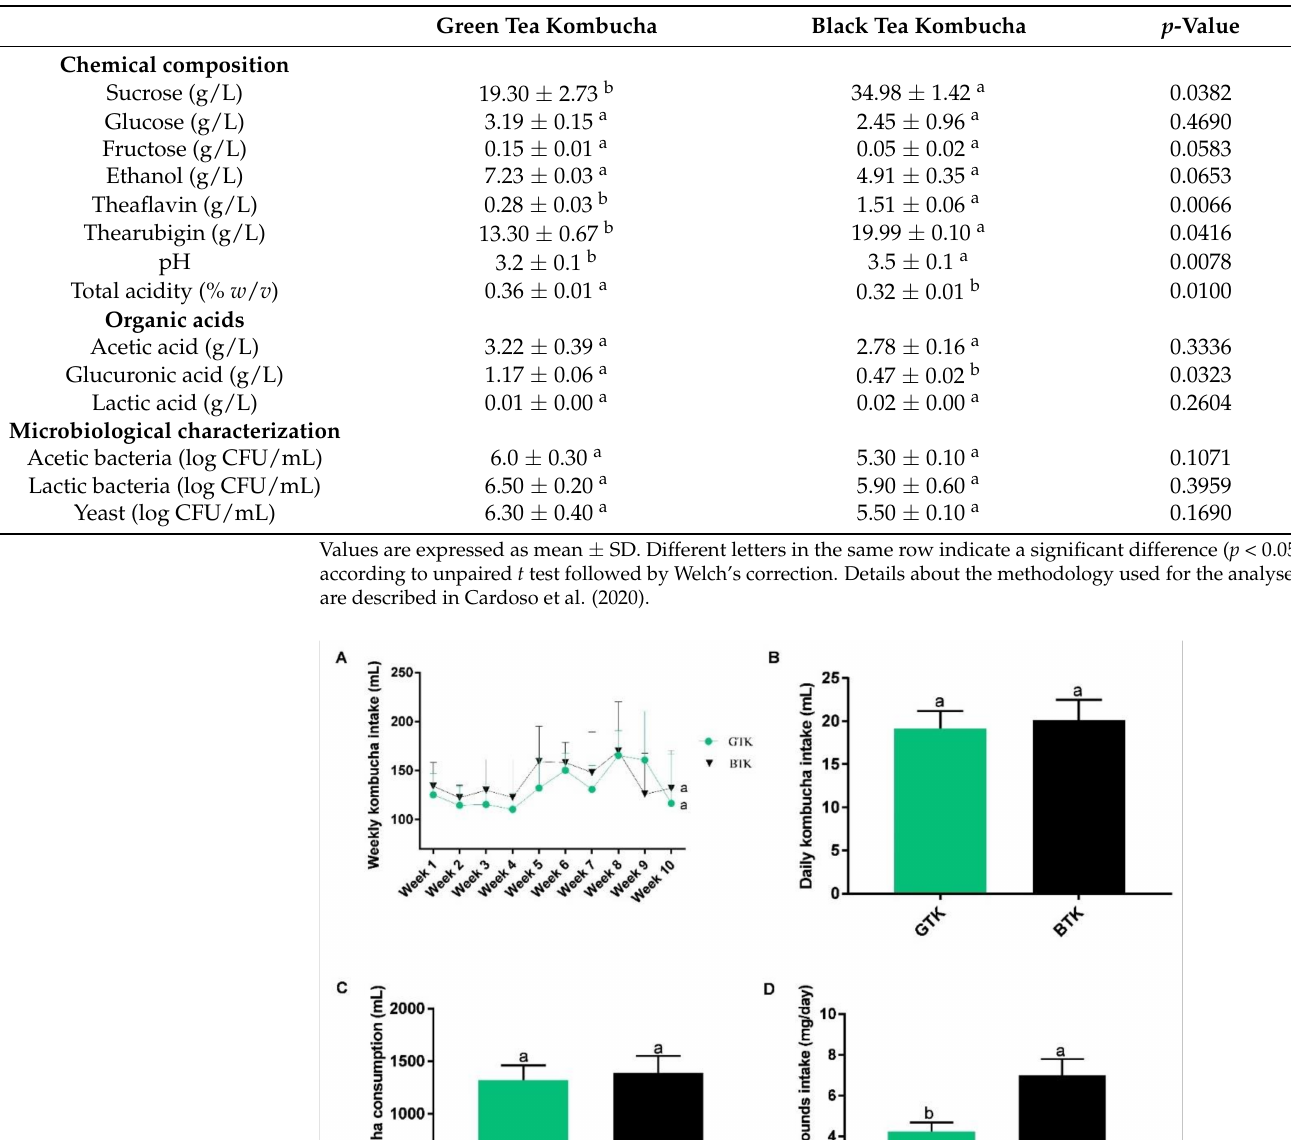
Table 1. Green and black tea kombuchas chemical characterization.